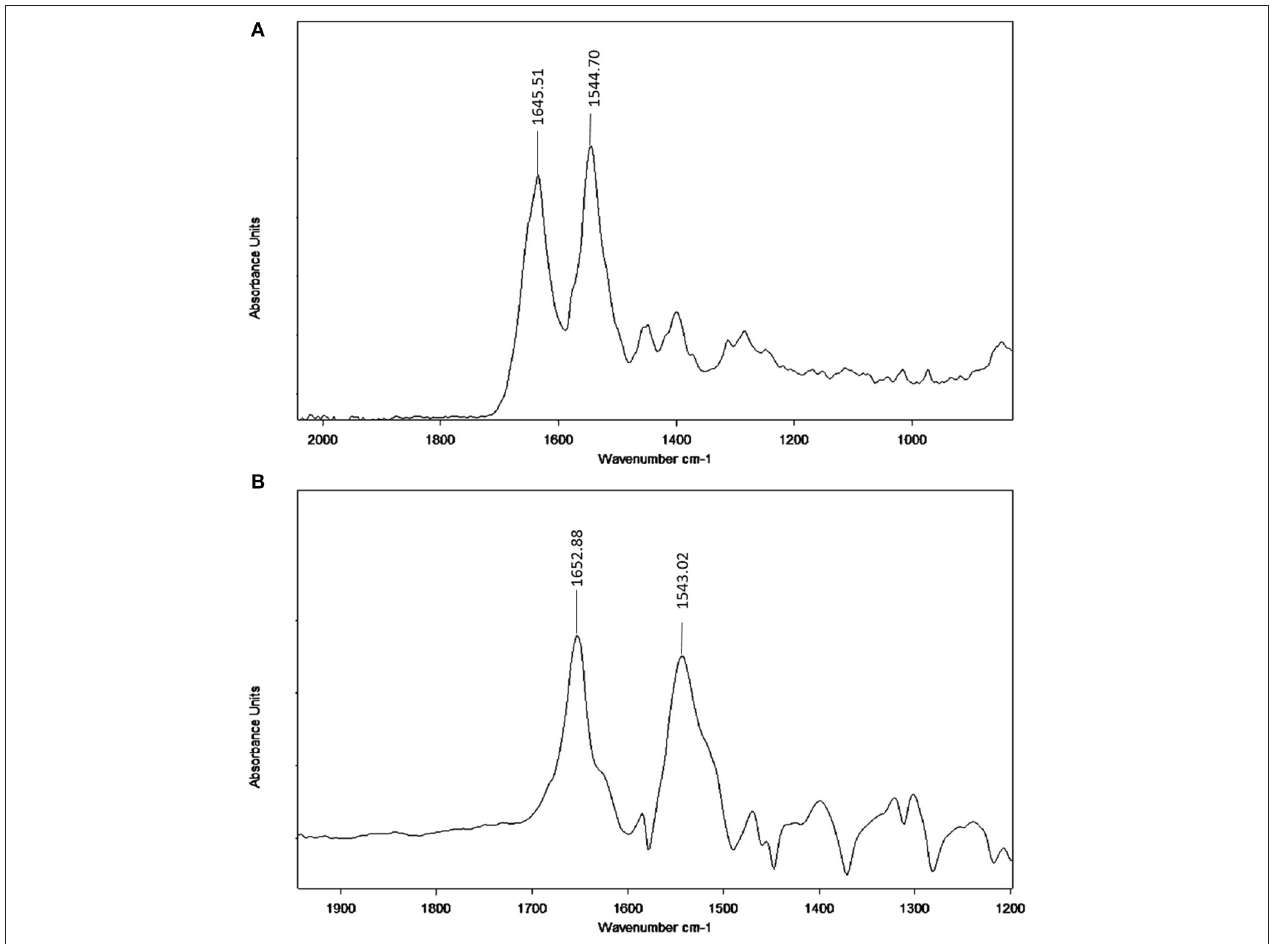
FIGURE 7 | FT-IR spectra (A) Free BSA in aqueous solution; (B) Difference spectra obtained by subtracting the spectrum of the neratinib-free form from that of the neratinib-bound form.